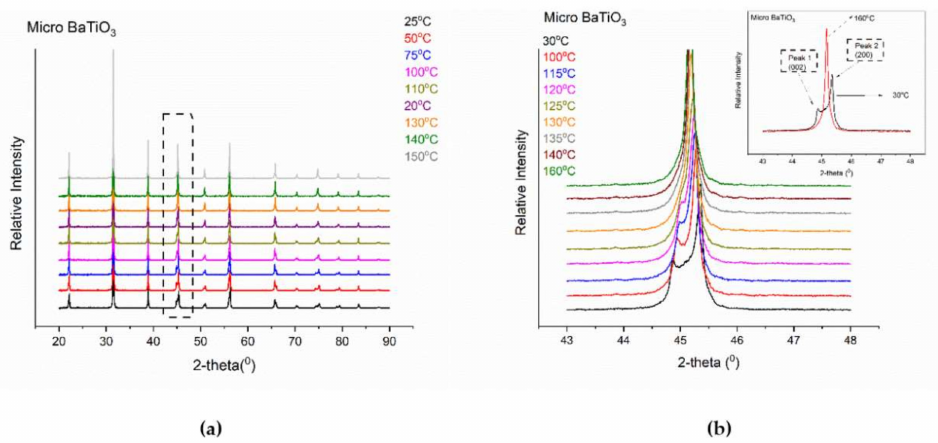
Figure 2. XRD patterns of micro-BT particles performed under the following experimental conditions: ◦ ( a ) increment = 0.02 and scan speed = 0.5s and ( b ) increment = 0.01 ◦ and scan speed = 10 s. Inset shows the XRD patterns at 30 ◦ C and 160 ◦ C